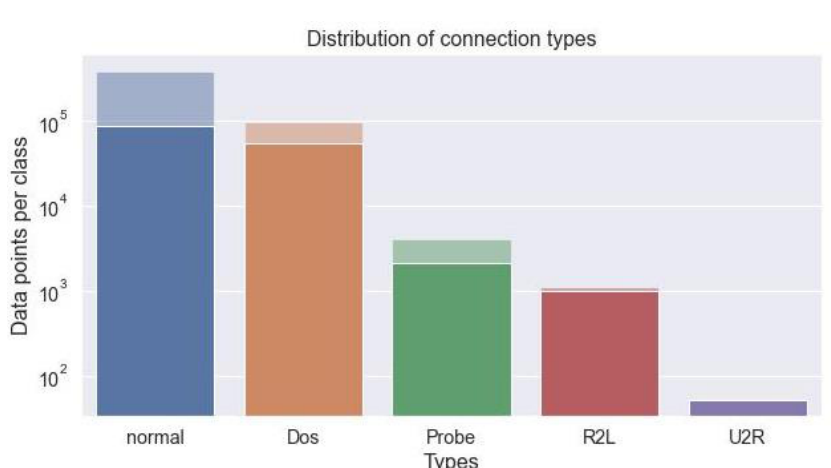
Figure 2. Distribution of data before removal of duplicates.